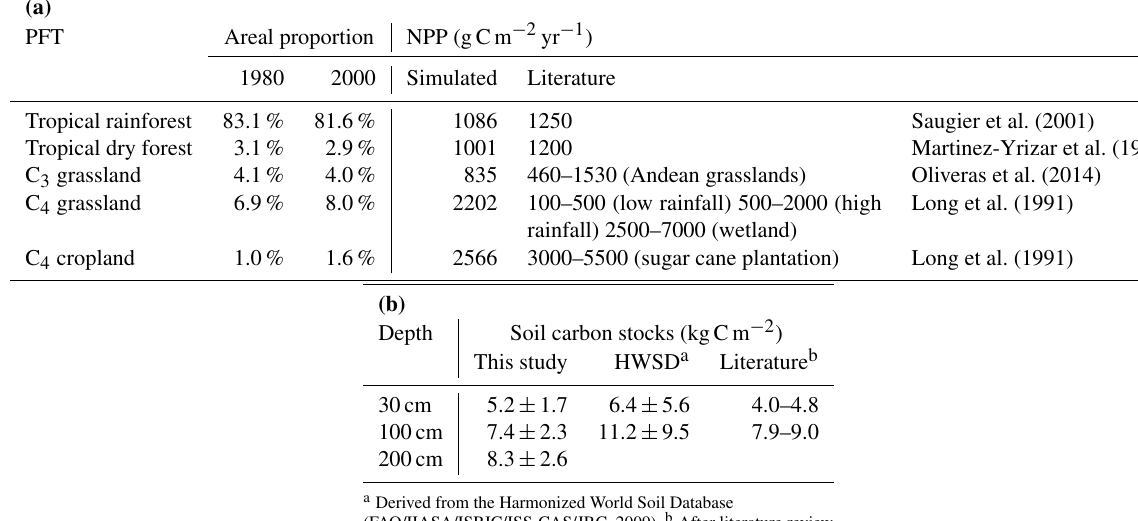
Table 4. (a) Yearly-mean simulated NPP in the Amazon basin (period 1980–2000) reported for the five dominant plant functional types (PFTs). (b) Simulated and observed mean soil organic carbon (SOC) stocks in the Amazon basin. Values are reported for the top 30cm, the top 100cm and the whole 200cm profile used in the